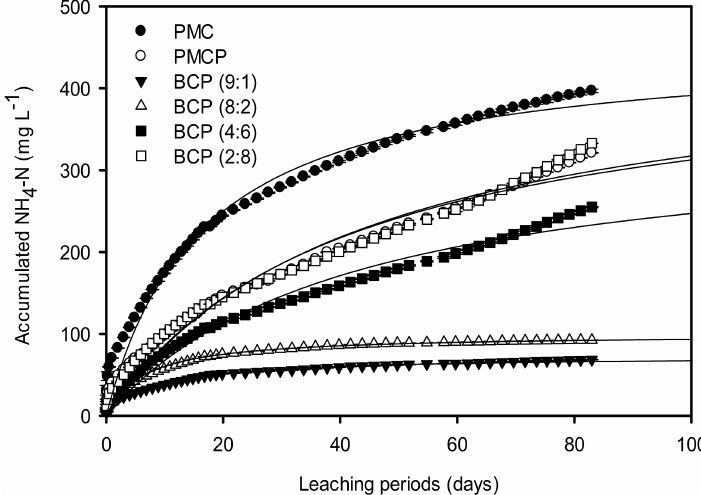
Figure 2. Effects of NH 4 -N accumulated concentrations in the releasing water from biochar pellet blended with various ratios of pig manure compost during leaching periods.